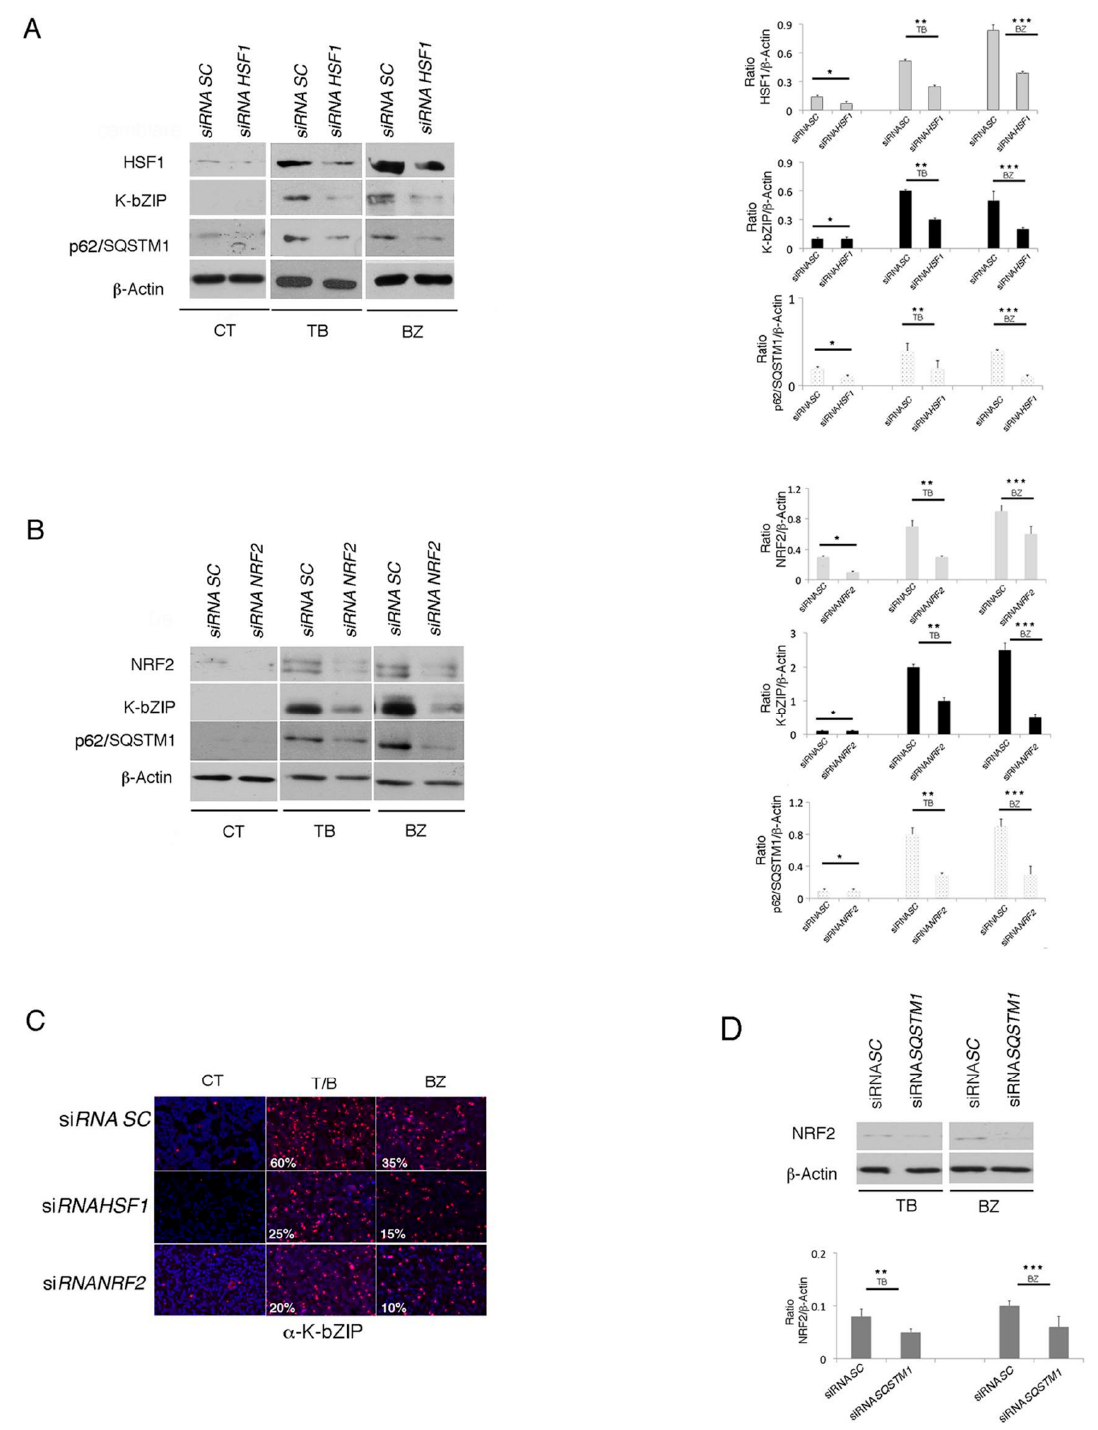
Figure 7. HSF1 and NRF2 RNA interference reduces K-bZIP expression in TB- or BZ-treated PEL cells. ( A ) HSF1 and ( B ) NRF2 knocking-down by specific siRNA decreased K-bZIP and p62/SQSTM1 expression in BCBL1 treated with TB or BZ. Densitometric analysis was performed using Image J software and the ratio of K-bZIP, HSF1, NRF2 or SQSTM1 versus β -Actin was calculated. Histograms represent the mean ± standard deviation (SD) of at least three independent experiments. p * < 0.05 (siRNA HSF1 or siRNA NRF2 vs siRNA SC ), p ** < 0.05 (siRNA HSF1 or siRNA NRF2 vs siRNA SC , TB-treated) and p *** < 0.05 (siRNA HSF1 or siRNA NRF2 vs siRNA SC , BZ-treated). ( C ) Immunofluorescence analysis of K-bZIP expression (red) in HSF1 and NRF2 knocked-down cells treated for 24 h with TB or BZ. DAPI was used to stain nuclei (blue). Percentage of K-bZIP-positive cells is also indicated. Objective magnification 20×. ( D ) NRF2 expression in SQSTM1 knocked-down cells, induced to lytic replication by TB or BZ, as evaluated by western blotting. Densitometric analysis